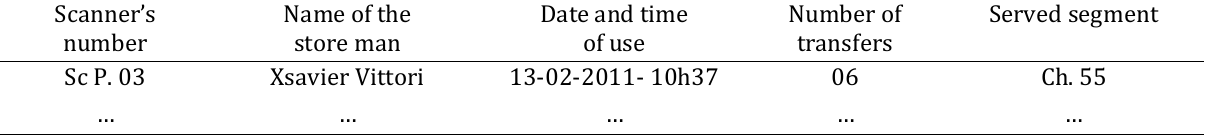
Date and time Number of Served segment of use transfers